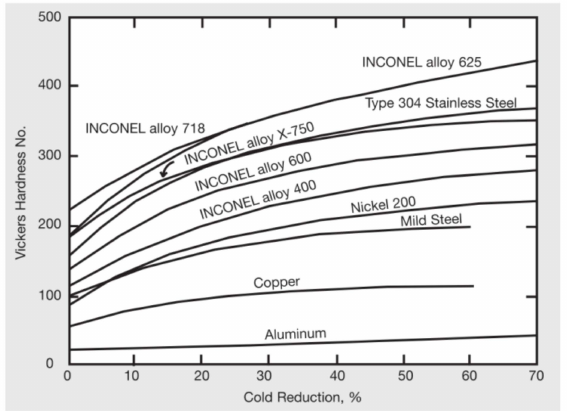
Figure 3. Effect of cold work on hardness for different INCONEL ® alloys and comparison with other materials